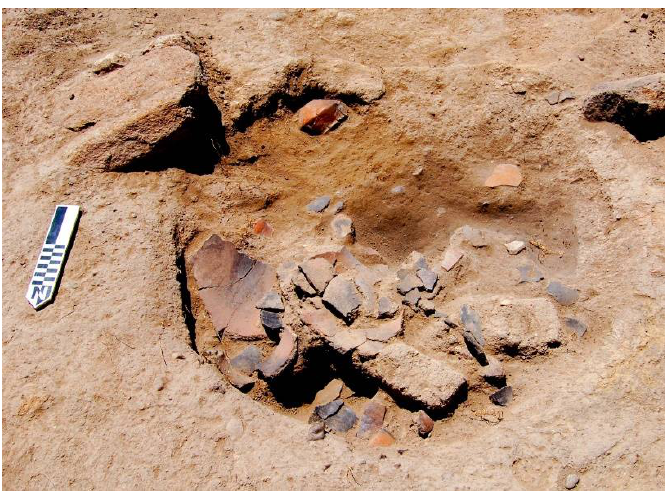
Figure 5. Photo of the foundation deposit (F180/L169) under the Agglutinated phase floor of the Non-Domestic area.